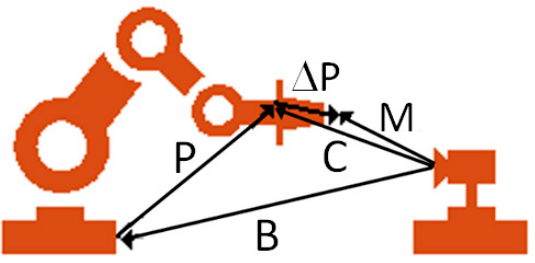
Figure 13. Calibration transformations [28].